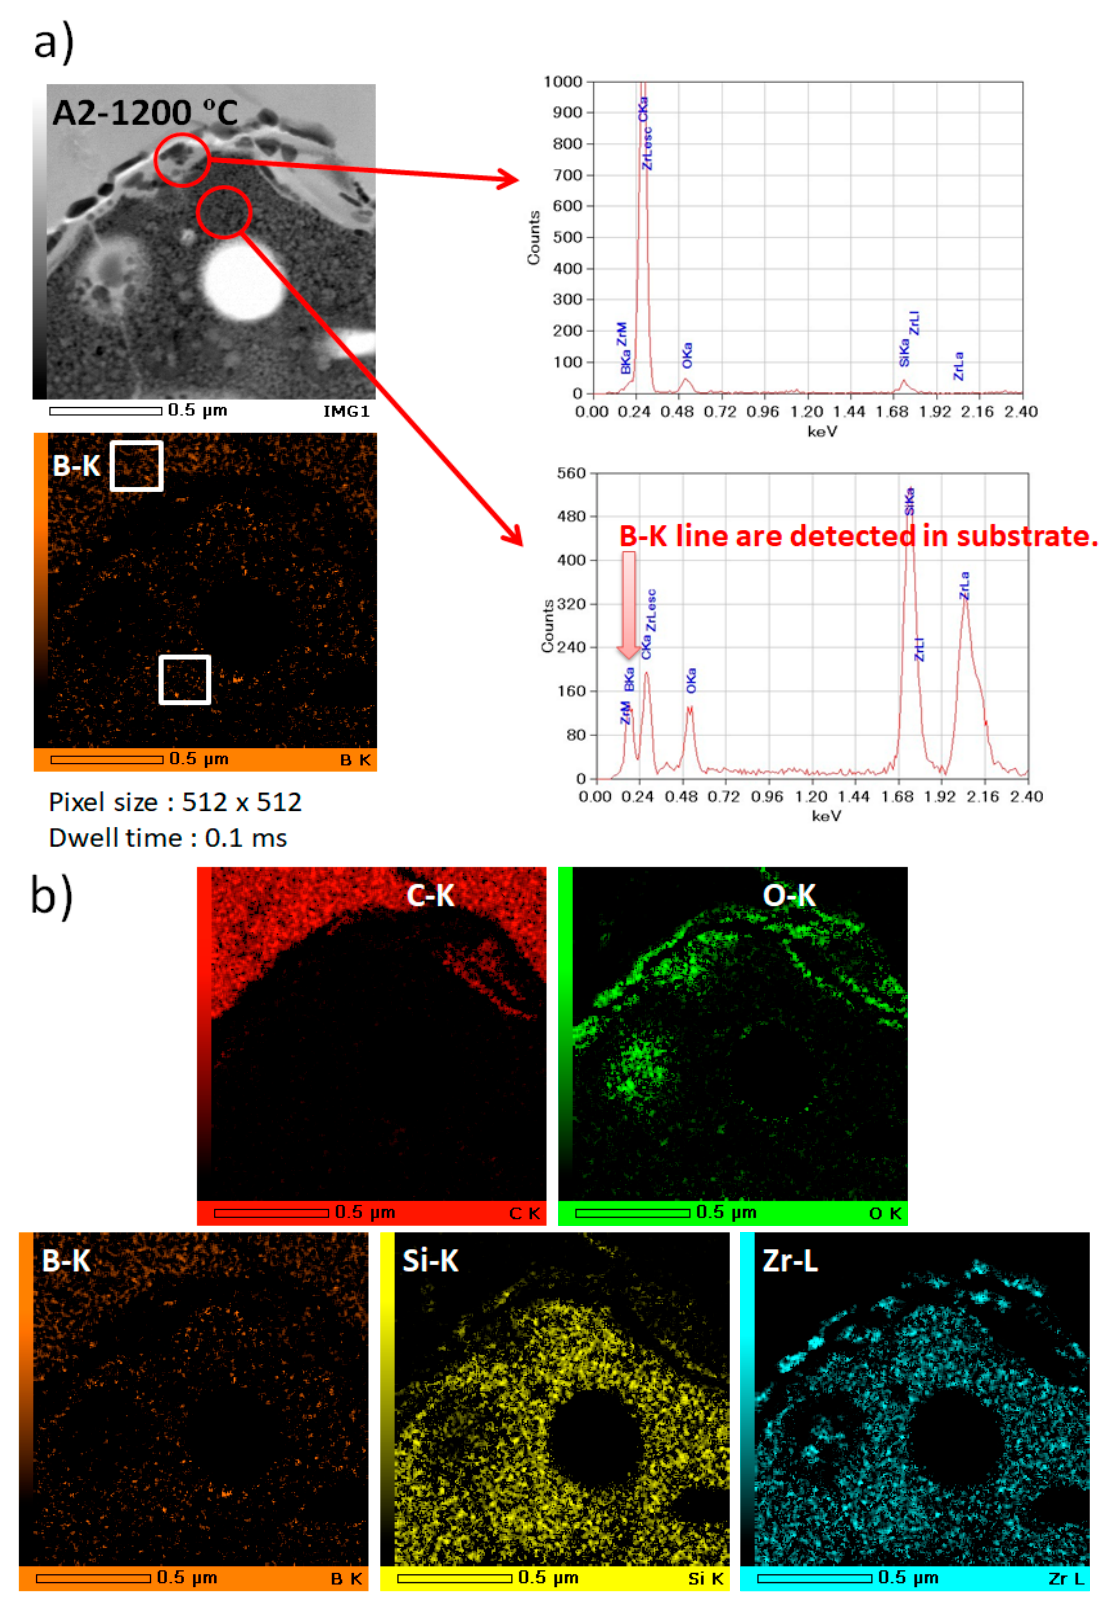
Figure 14. EDS/STEM analysis of coated sample A2 ( a ): STEM image with an arrows indicating the EDX line scan position with Si K α signal and B K α signal of the particles; ( b ): the distributions of elements in 70%SiC-30%ZrB 2 at 1200 º C.